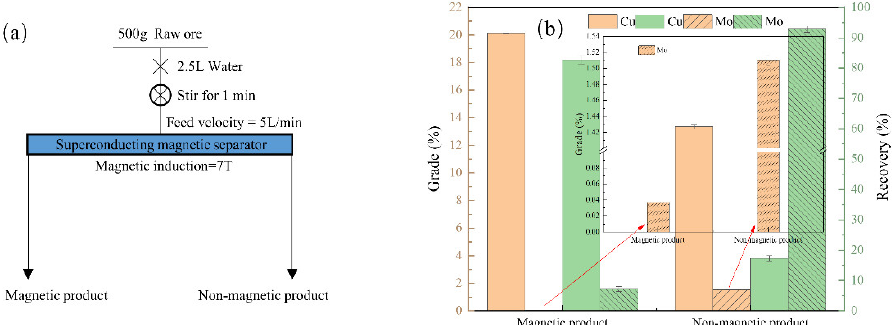
Figure 8. Flow sheet and results of superconducting magnetic separation at a magnetic induction of 7 T, a pulp concentration of 20%, and a feed velocity of 5 L/min. ( a ) Flow sheet; ( b ) Results.